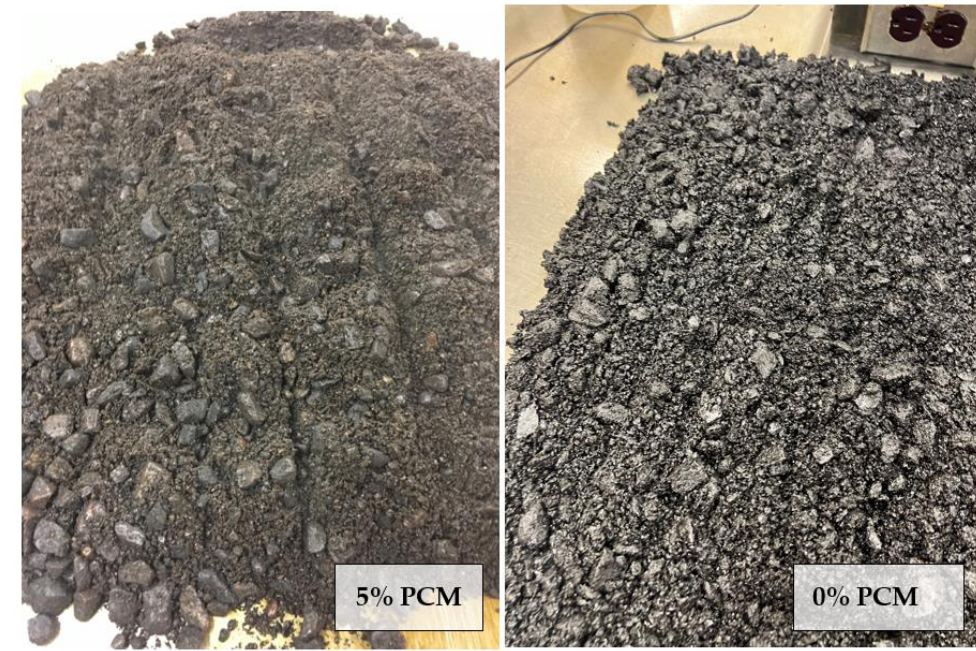
Figure 3. Asphalt mix containing 5%PCM and 0%PCM.